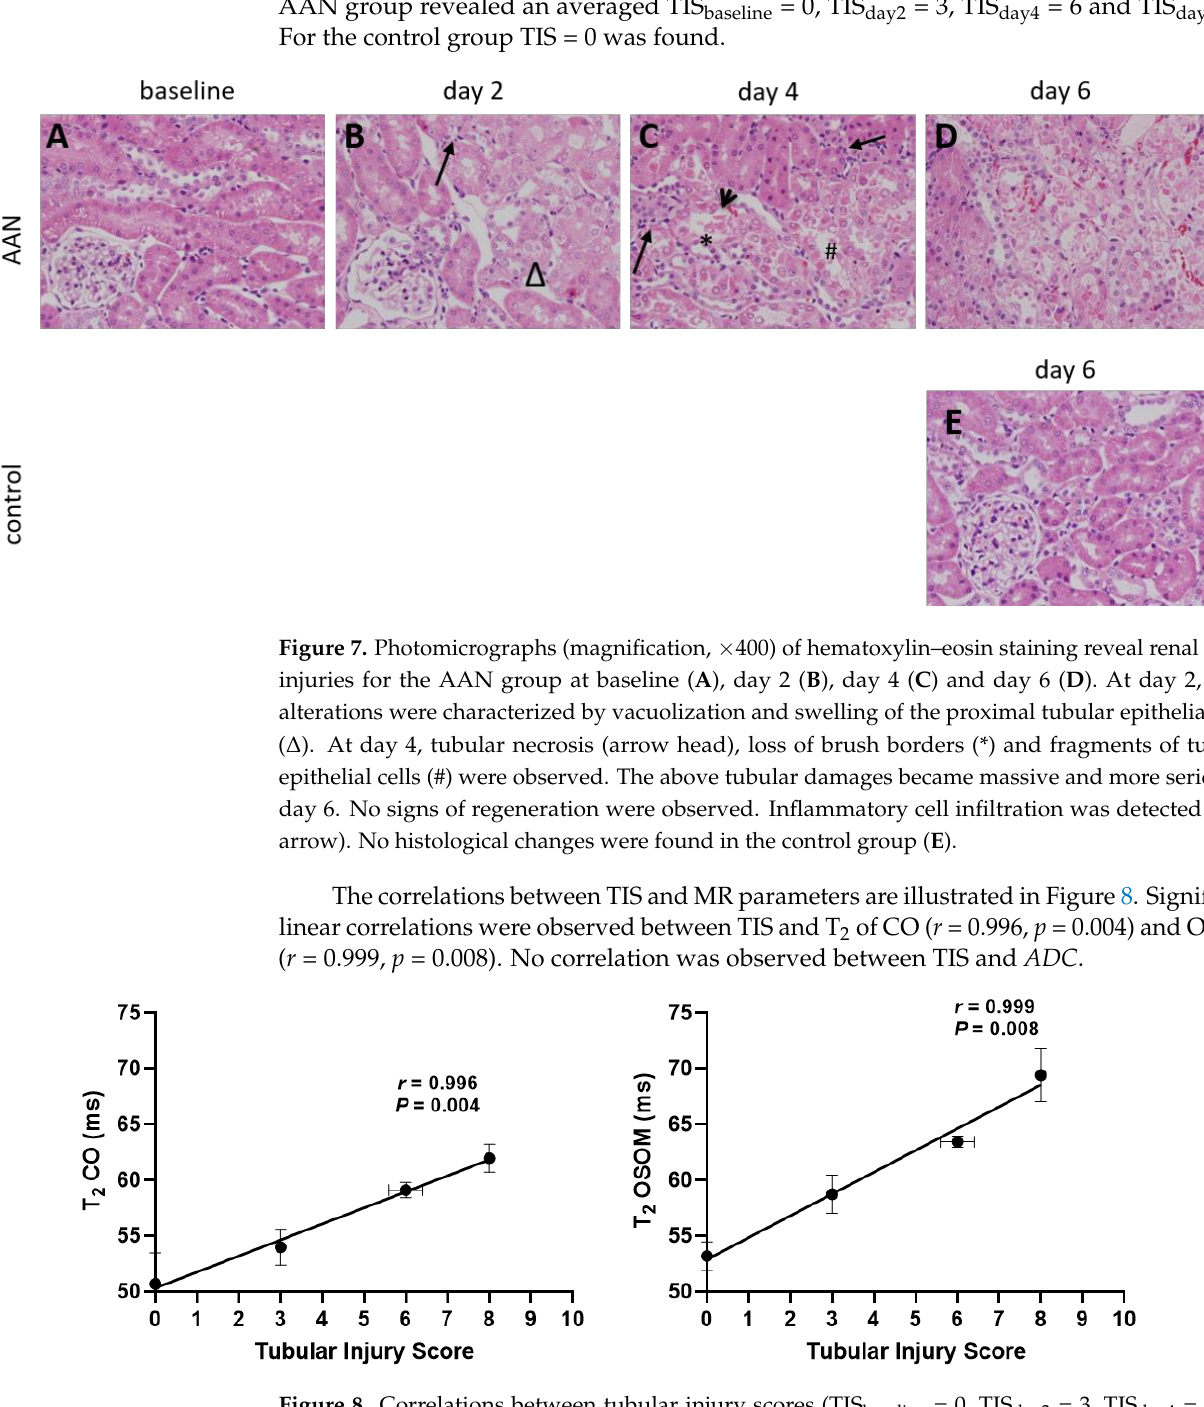
Figure 8. Correlations between tubular injury scores (TIS baseline = 0, TIS day2 = 3, TIS day4 = 6 and TIS day6 = 8) and MRI parameters. CO, cortex; OSOM, outer stripe of outer medulla. Table 1. Summary of T 2 relaxation times obtained for the AAN group and for the control group. T 2 (ms)